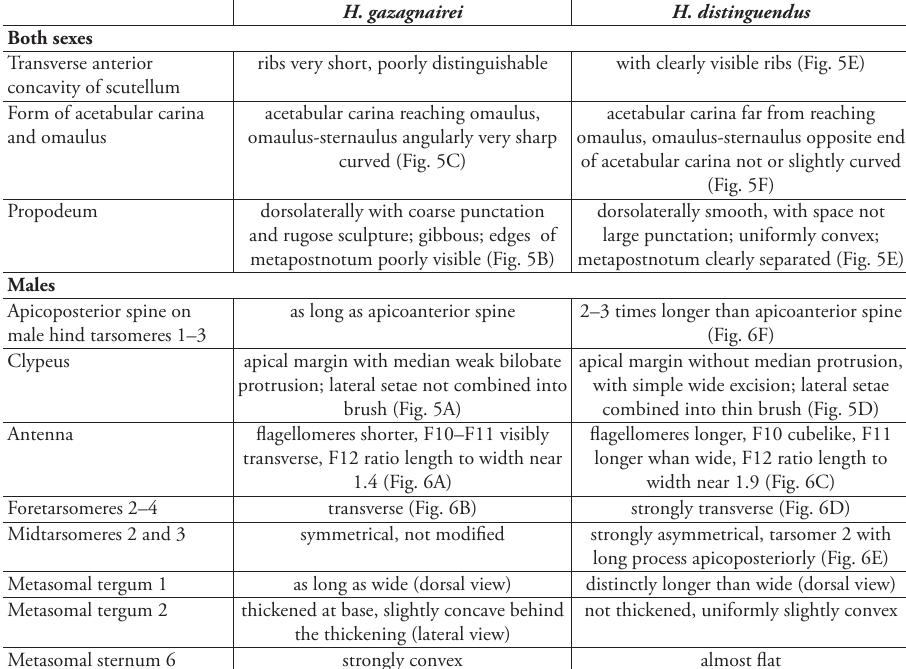
Table 1. Comparison of morphological features of Hoplisoides gazagnairei and H. distinguendus . H.